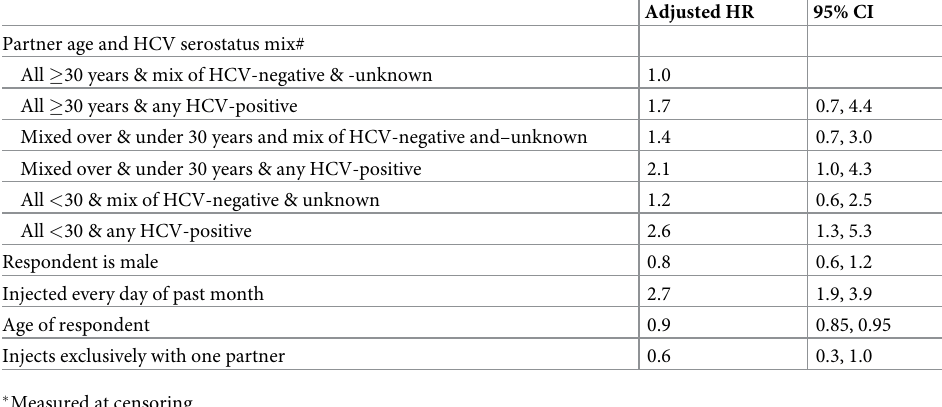
Adjusted HR 95% CI